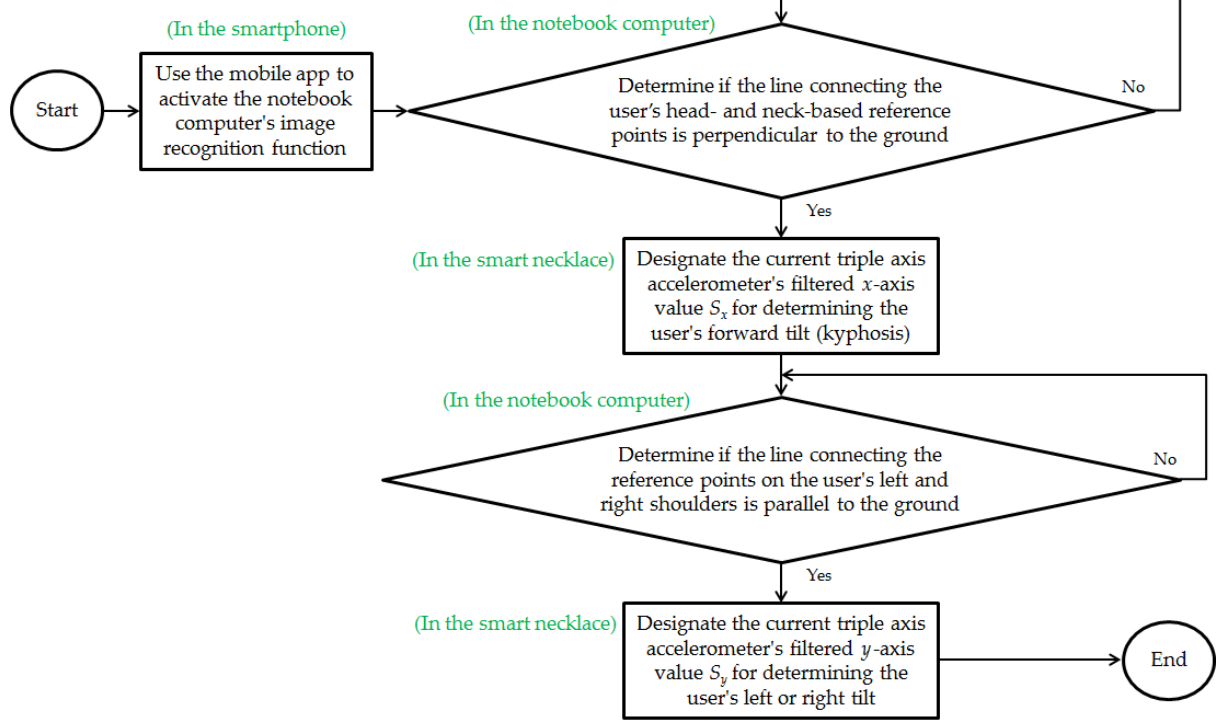
Figure 4. Interrelationship flowchart of the 3 subsystems when a new user utilizes the notebook computer’s image recognition function to perform an automatic calibration of the smart necklace’s internal